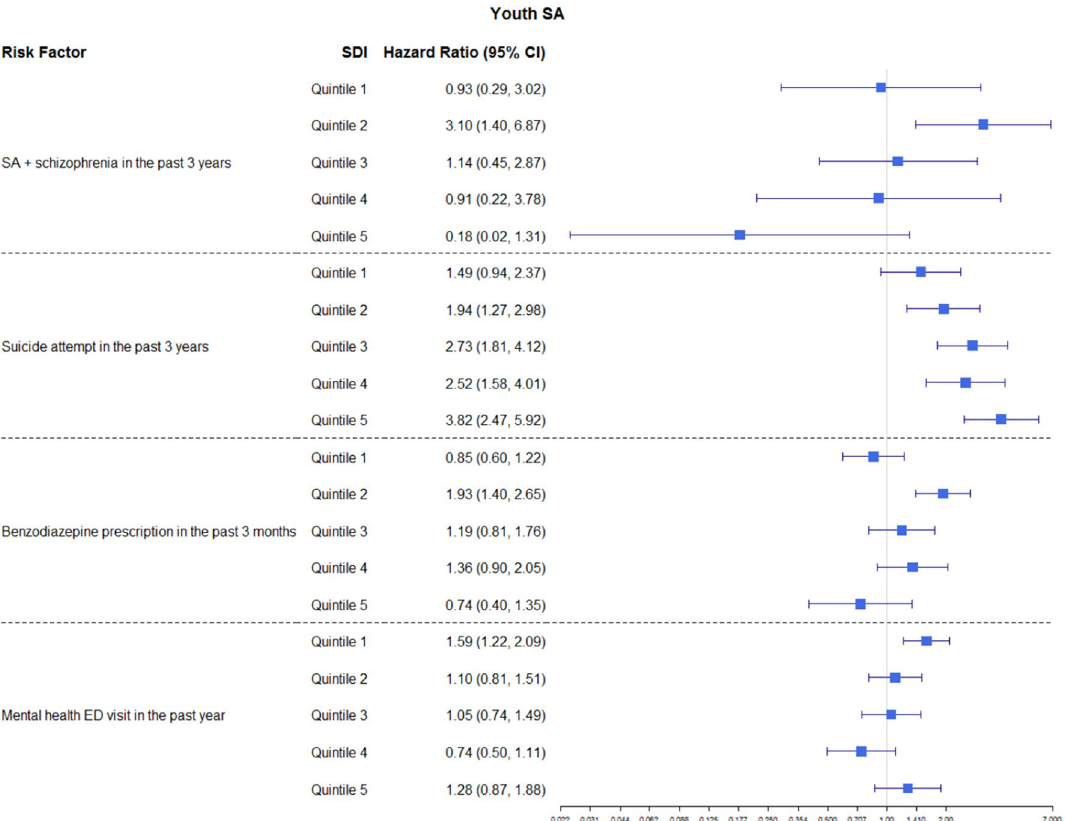
Figure 3. Hazard ratios of risk factors by SDI for youth suicidal attempt (SA) where the interactions were